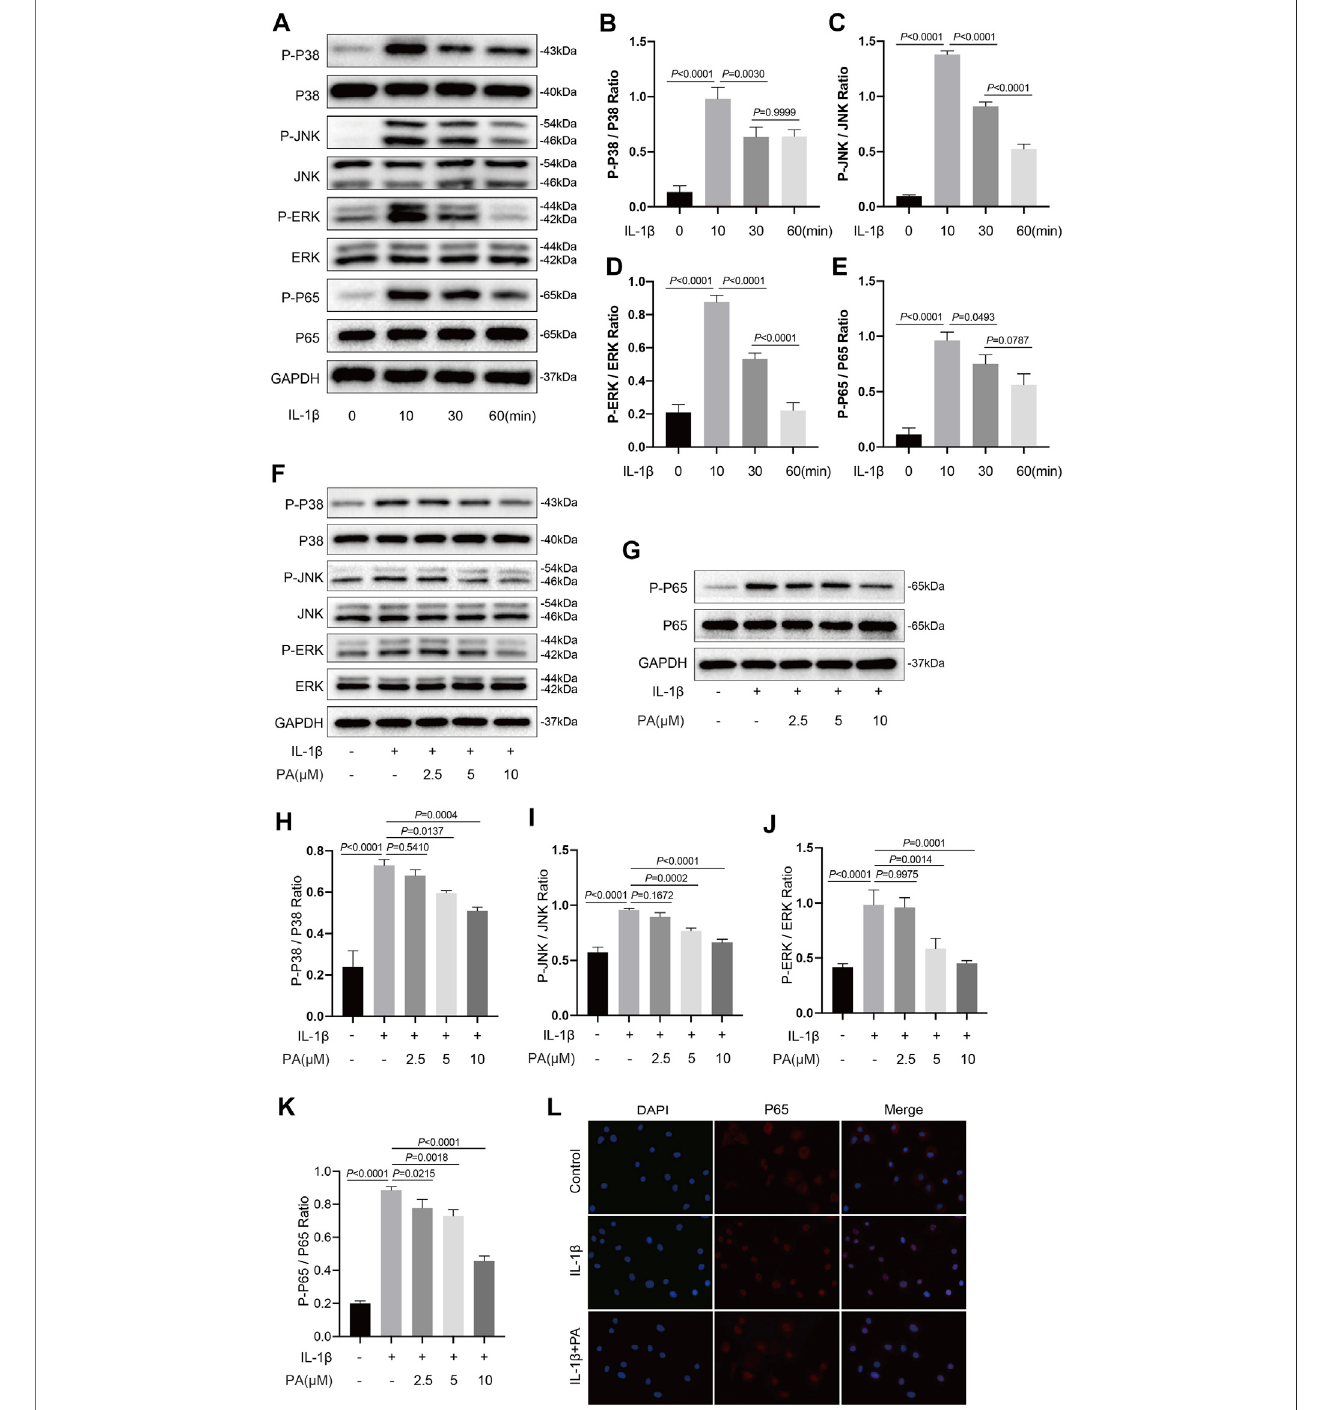
FIGURE5| PAinhibitedtheIL-1 β -inducedactivationofMAPKandNF- κ Bsignalingpathways. (A) Westernblotsand (B – E) quantitativeanalysisofMAPKpathway relatedproteins (P-P38,P38, P-JNK, JNK, P-ERK, and ERK) and NF- κ B pathway related proteins (P-P65, P65)in IL-1 β -induced chondrocytes atthe time points (0, 10, 30,and60 min). (F,G) Westernblottingresultsand (H – K) quanti fi cationanalysisofMAPKpathwayrelatedproteins(P-P38,P38,P-JNK,JNK,P-ERK,andERK)andNF- κ Bpathwayrelatedproteins(P-P65,P65)inchondrocytespretreatedwiththeadministrationofPA(2.5,5,and10 μ M)for24 handfollowedthestimulationof5 ng/ ml of IL-1 β for 10 min. (L) Nuclear translocation of P65 was detected by immuno fl uorescence staining after chondrocytes pretreated with the administration of PA (10 μ M) for 24 h and followed the stimulation of 5 ng/ml of IL-1 β for 10 min (scale bar 200 μ m). Non-phosphorylated protein (P38, JNK, ERK, and P65) was used as an internal control. Data are presented as means ± SD ( n (cid:1) 3) and the exact p value was marked in the corresponding fi gure and p < 0.05 was considered statistically signi fi cant.